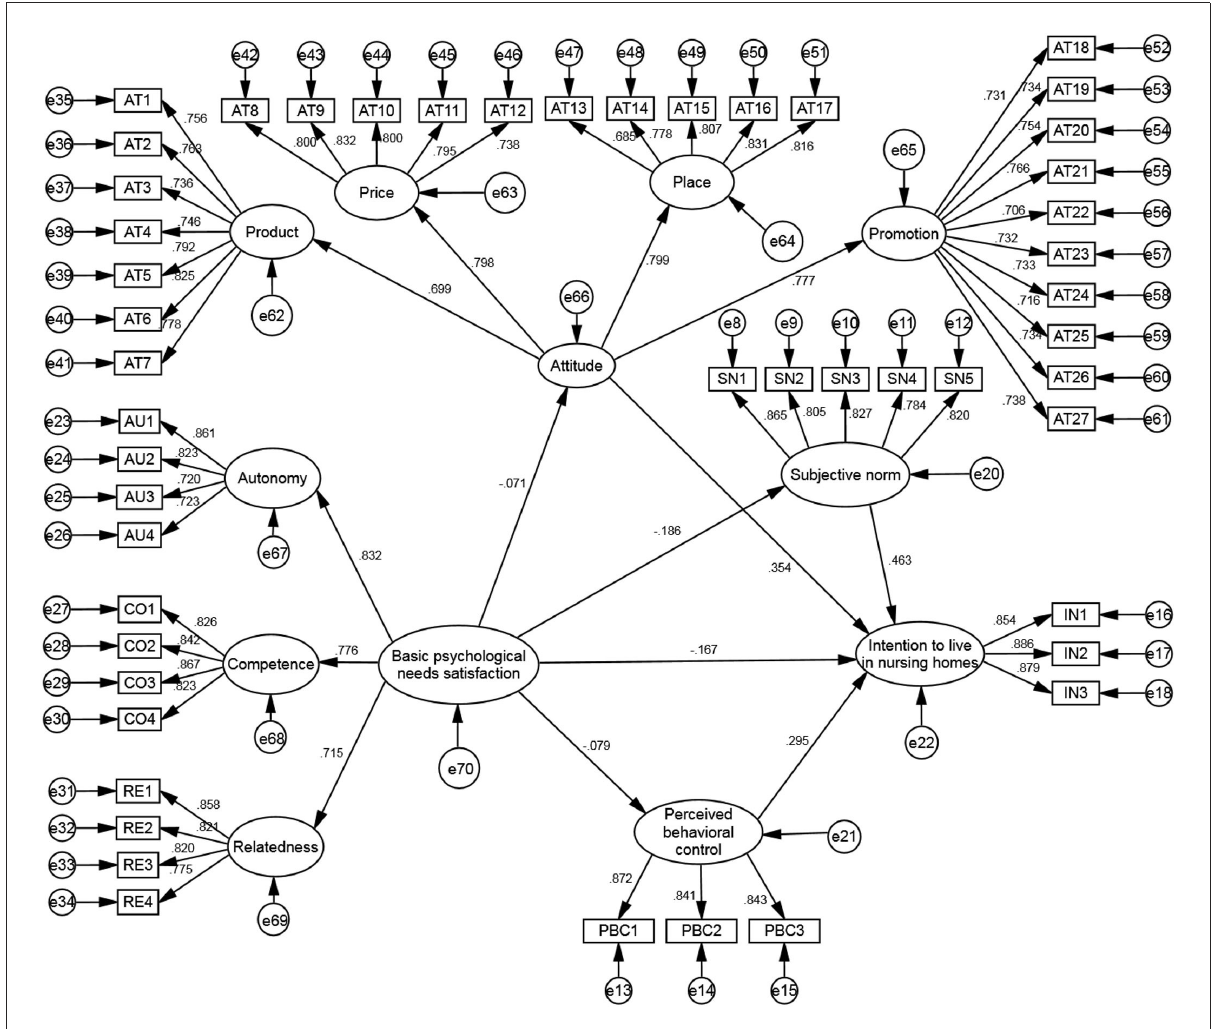
FIGURE2 Structural equation